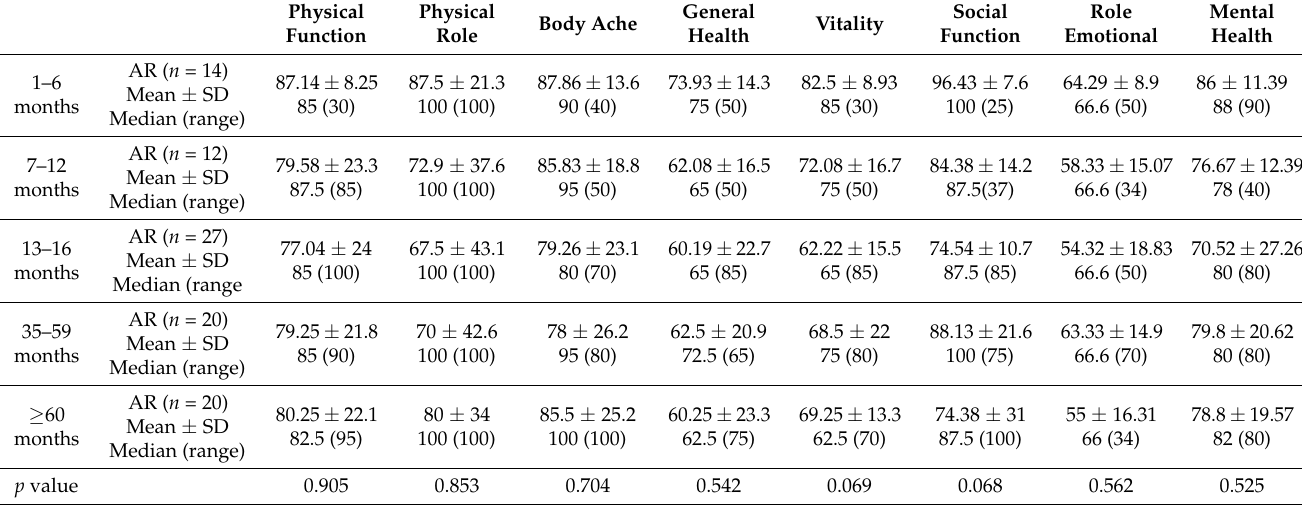
Table 3. Scores obtained on the health scales of the SF-36 Questionnaire in the OAR group of patients according to the time elapsed since the intervention. Open abdominal repair (OAR), abdominal repair (AR).